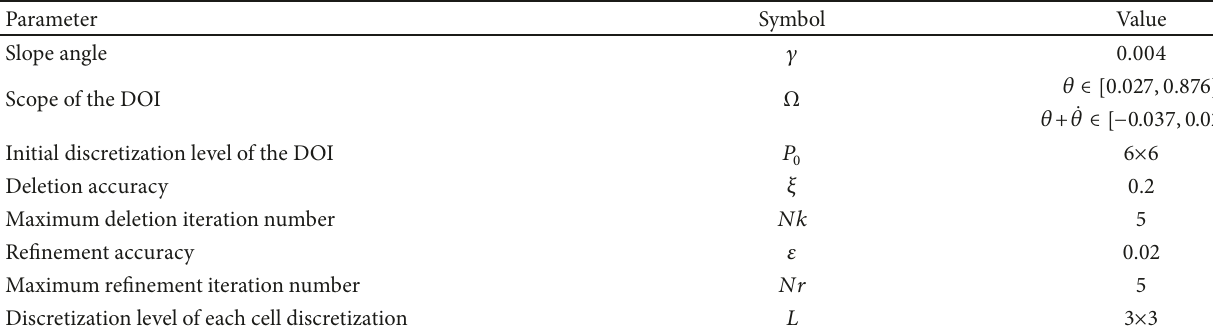
Figure 3: The simplest passive biped walker is walking on a slope. (a) The swing phase; (b) the collision event. Table 1: Simulation parameters of the MICM